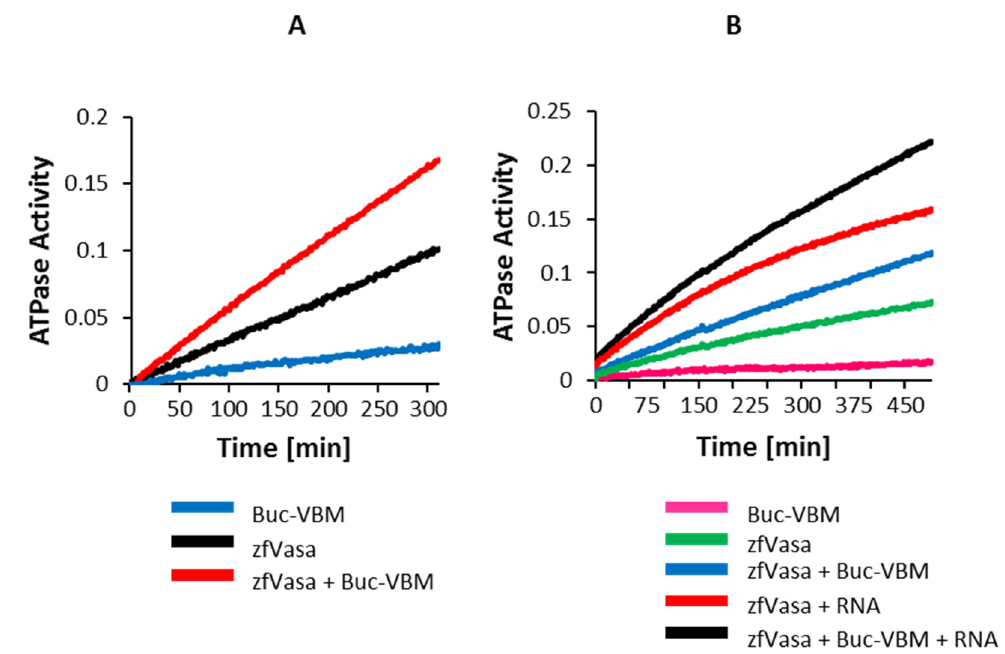
Figure 5. Buc-VBM activates Vasa helicase activity. ( A,B ) The Y-axis denotes the ATPase activity as a function of the reduction of NADH absorption at 340 nm. The X-axis denotes the incubation time in minutes. The data presented are averaged from three independent experiments. ( A ) The incubation of 100- µ M Buc-VBM with 2.5-mM ATP showed very mild ATPase activity (negative control, blue line). A higher background ATPase activity was observed after the incubation of 5- μ M zfVasa with 2.5-mM ATP (black line). Fascinatingly, the ATPase activity was approximately doubled when 100- μ M Buc-VBM was added to 5- μ M zfVasa and 2.5-mM ATP. ( B ) The incubation of 100- μ M Buc-VBM with 2.5-mM ATP showed mild ATPase activity (pink line). The incubation of 5- μ M zfVasa with 2.5-mM ATP displayed relatively higher ATPase activity (green line). The incubation of 5- μ M zfVasa with 50- μ M ssRNA showed enhanced ATPase activity (red line) compared to 5- μ M zfVasa with 100- μ M Buc-VBM (blue line). zfVasa ATPase activity was further enhanced in the presence of ssRNA and Buc-VBM (black line).